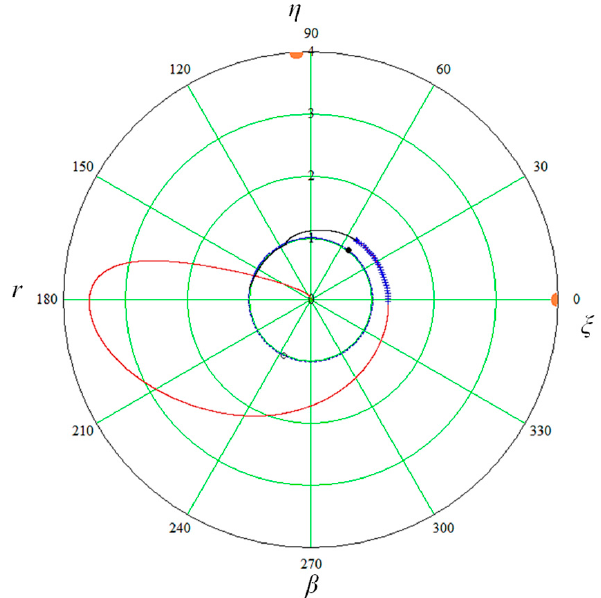
Figure 25. Relative selenocentric distance r M [undim.] of the SC to a circular orbit of a given radius (enlarged). Two points of intersection of the curve and the time axis are clearly visible, corresponding to the possible moments of entering a given circular orbit.